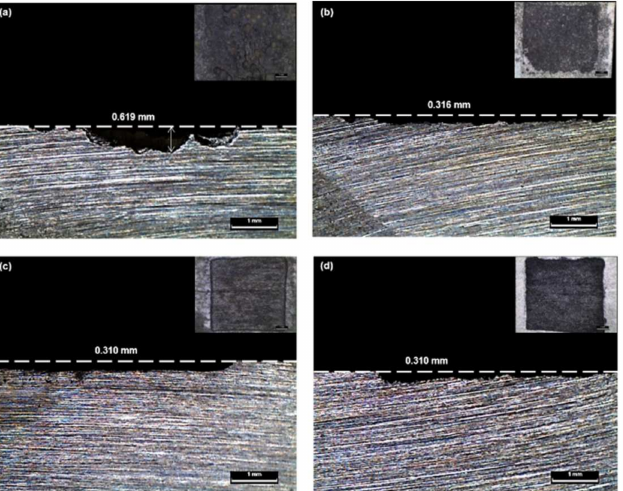
Figure 4. Cross-sectional images following the galvanostatic test at different applied current densities: ( a ) 0.096 mA/cm 2 ; ( b ) 0.96 mA/cm 2 ; ( c ) 9.6 mA/cm 2 ; ( d ) 96 mA/cm 2